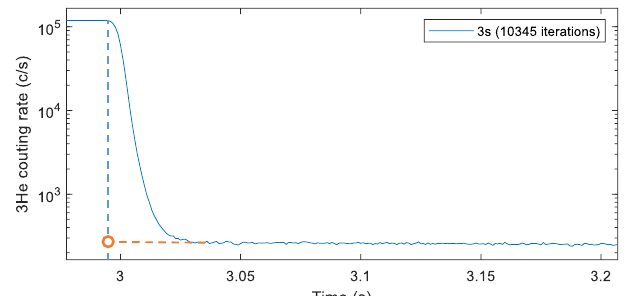
Fig. 7. Neutron emission of 239 Pu in the case of short irradiation cycles (3 s of irradiation).